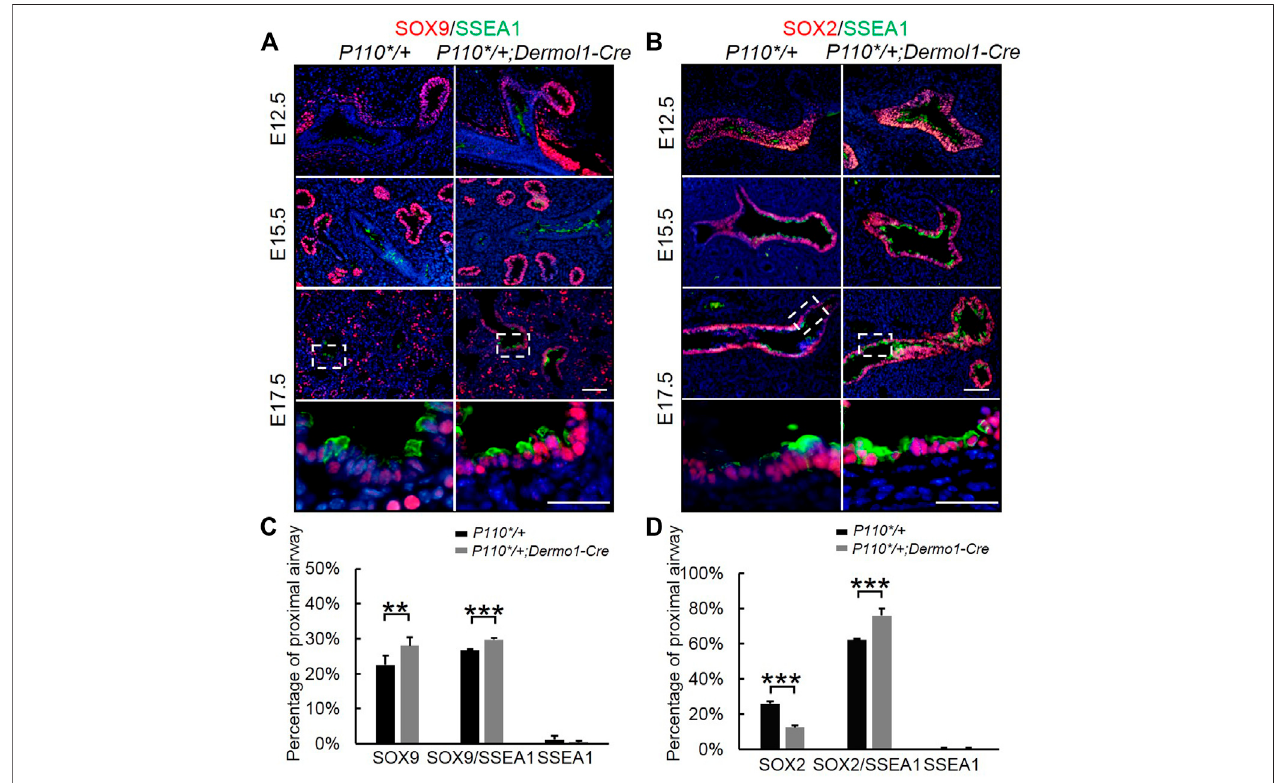
FIGURE 7 | Analyses of epithelial progenitor cell differentiation. (A,B) . Double IF staining analyses of SOX2, SOX9, and SSEA1 expression in E17.5 control and P110*/+ ; Dermo1-cre lungs. (C) .PercentagesofSOX9,SOX9/SSEA1,andSSEA1cellsinthetotalE17.5distalairwaycellswerecountedonmultiplerandom fi elds. N > 3. (D) . Percentages of SOX2, SOX2/SSEA1, and SSEA1 cells in the total E17.5 proximal airway cells were counted on multiple random fi elds. The bars represent the mean ± SD. N > 3. **p < 0.01 ***p < 0.001. Scale bar: 50 μ m.